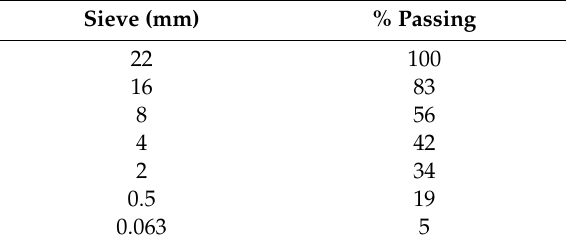
Table 1. Grading curve of the asphalt mixtures.